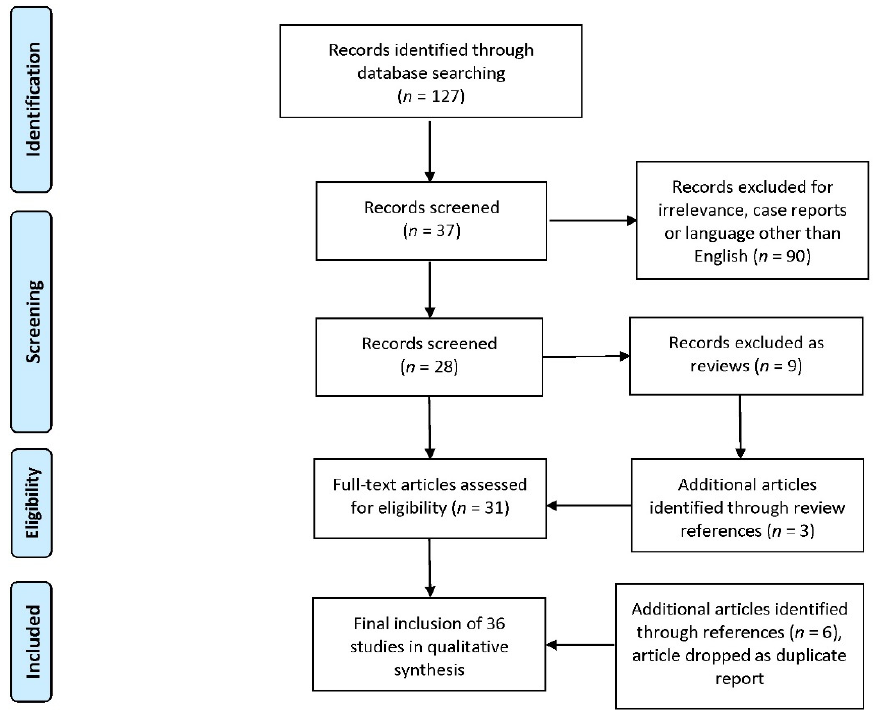
Figure 2. Flowchart of study selection according to PRISMA guidelines.